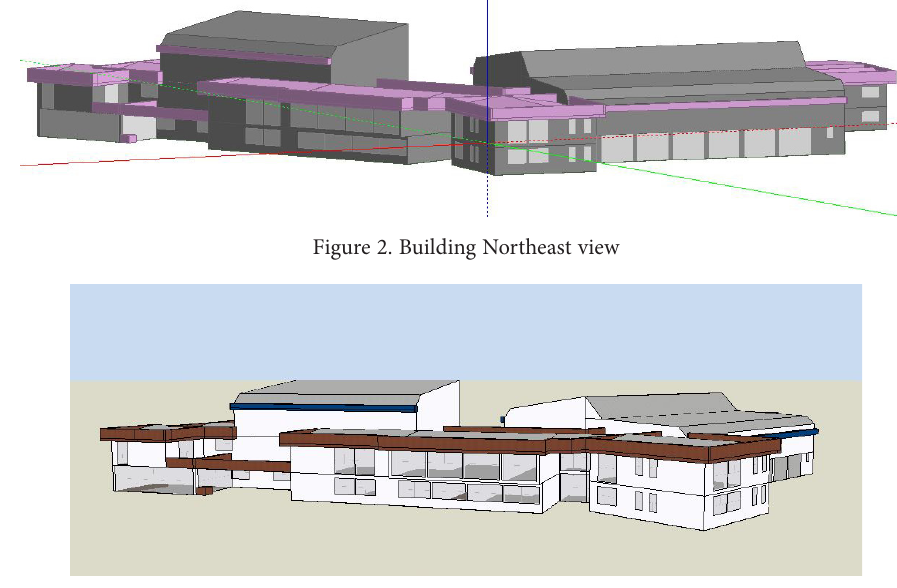
Figure 3. 3D model of the building in view